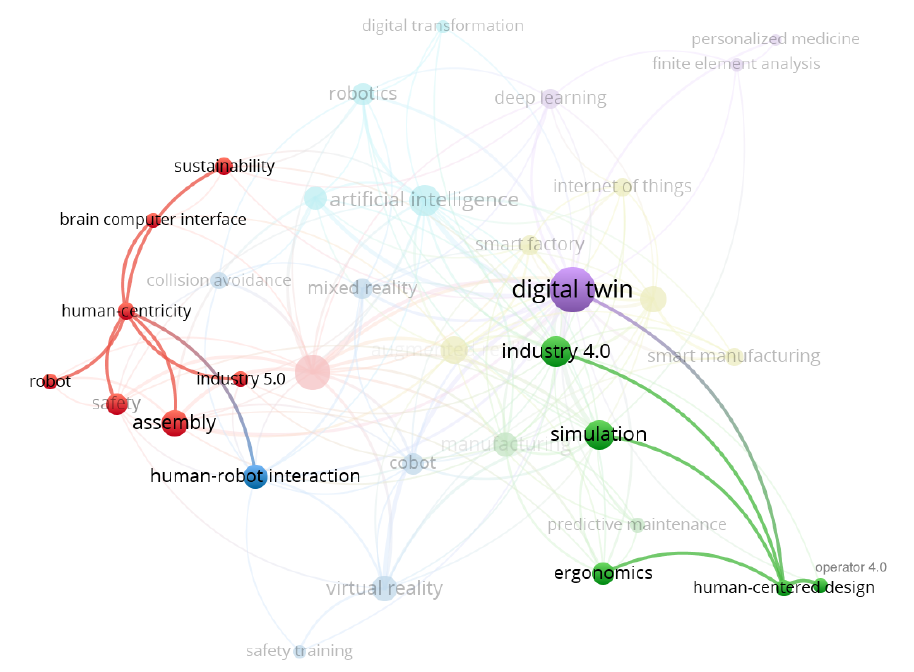
Figure 5. Human-centricity Co-occurrence Network